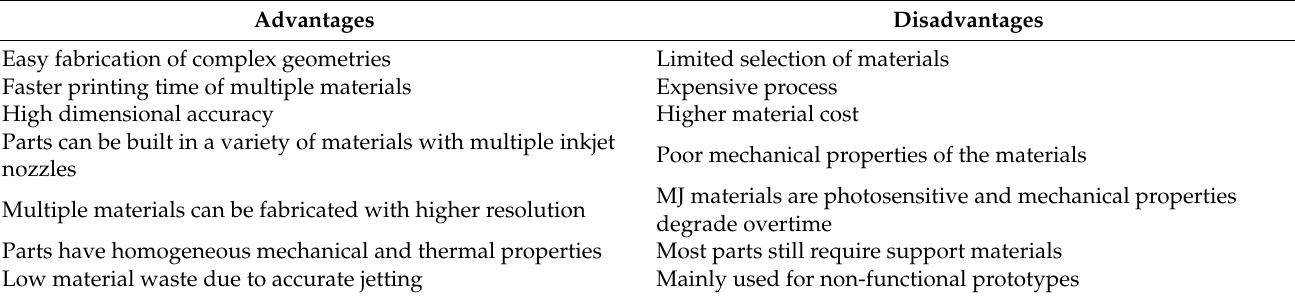
Figure 6. Process description of MJ. Table 1. Advantages and disadvantages of MJ process